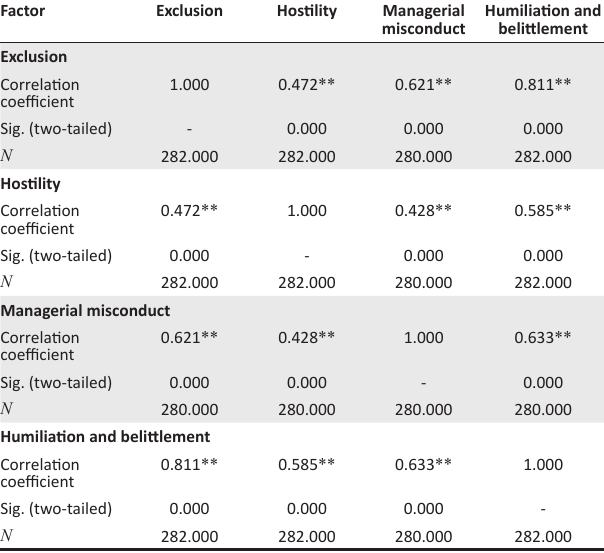
TABLE 5: Correlation between exclusion, hostility, managerial misconduct and humiliation and belittlement. Factor Exclusion Hostility Managerial